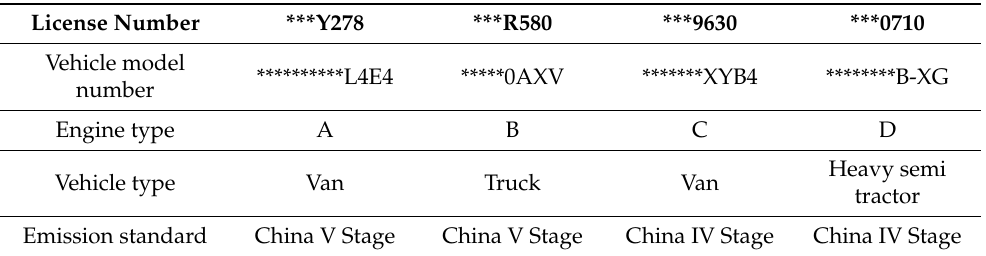
Table 1. The basic information of the vehicles under test (note that we use “*” to replace some letters or